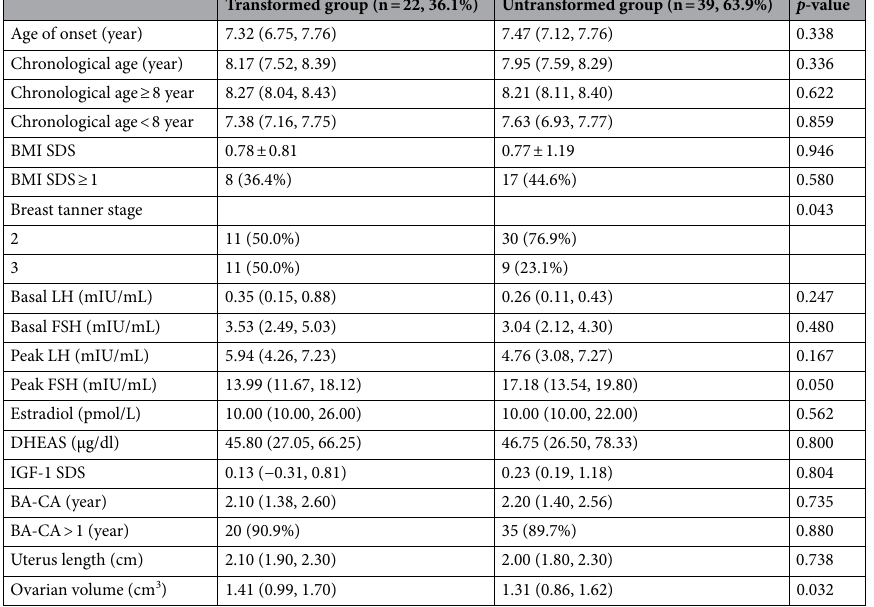
Table 2. Participant characteristics in the transformed and untransformed groups. BMI Body mass index, SDS Standard deviation score, LH Luteinizing hormone, FSH Follicle-stimulating hormone, DHEAS Dehydroepiandrosterone sulfate, IGF-1 Insulin-like growth factor-1, BA-CA bone age minus chronological age.